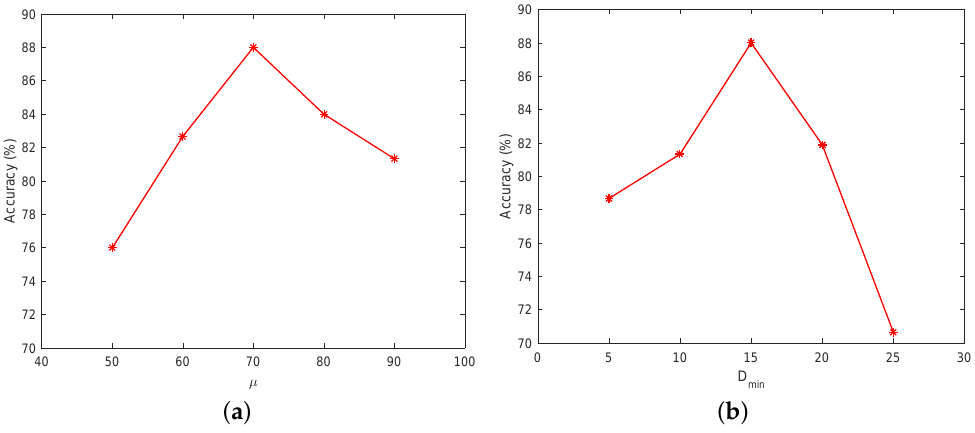
Figure 12. Accuracy of vehicle counting with different parameters (Moving background). We tested our method on a video of moving background scene with different parameters: ( a ) the effect of µ on accuracy when the value of D min is fixed to 15; and ( b ) the effect of D min on accuracy when the value of µ is fixed to 70.